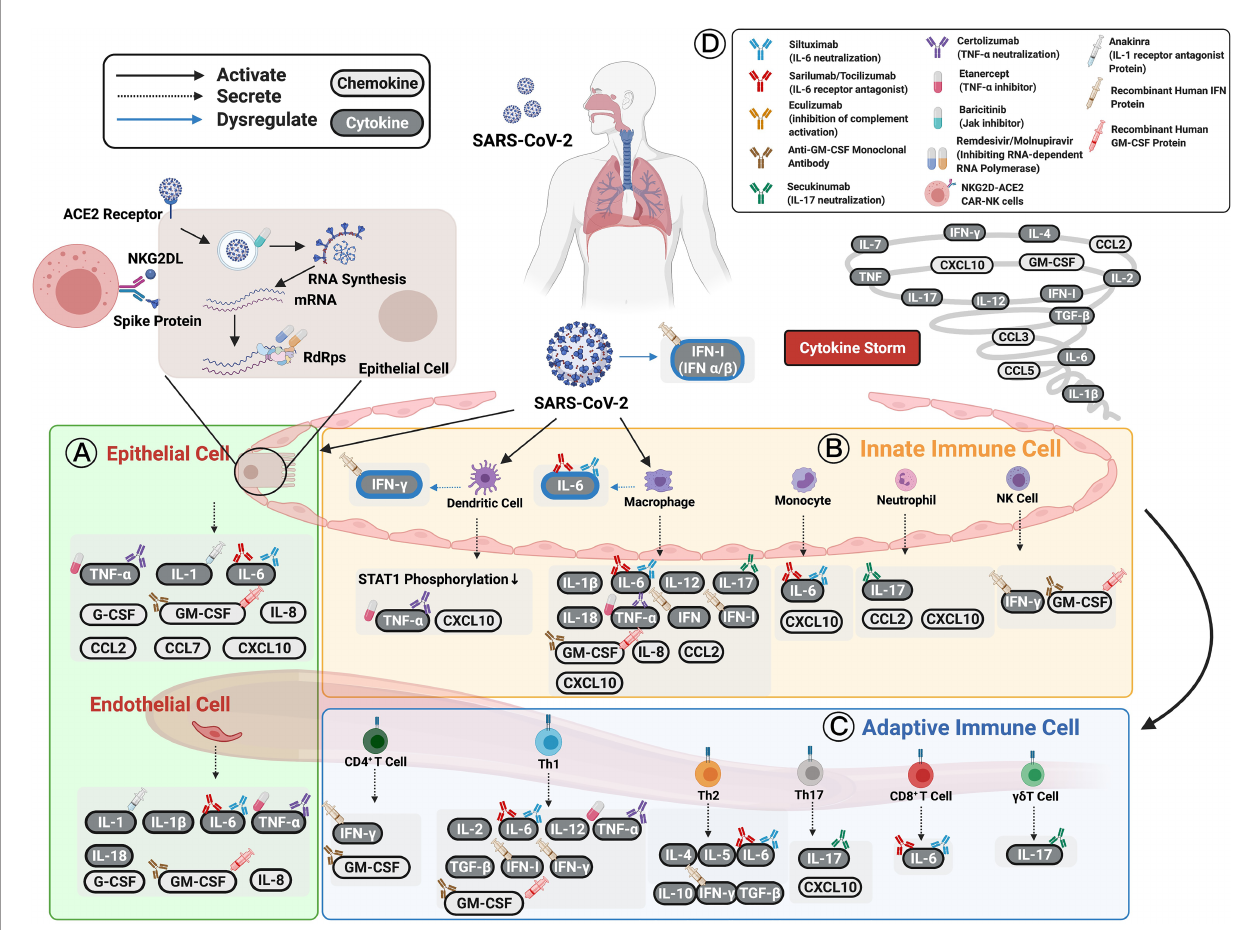
FIGURE 1 | Cytokines and chemokines expression induced by SARS-CoV-2 in patients with COVID-19. (A) Epithelial cells have been shown to express TNF- a , IL-1, IL-6, and other chemokines (e.g., IL-8, CCL2, CCL7, CXCL10, G-CSF, and GM-CSF) as well as initiate immune responses following infection. (B) Innate immune cells, including dendritic cells, macrophages, circulating monocytes, neutrophils, and NK cells, are activated by SARS-CoV-2 infection to secrete various cytokines and chemokines to enhance both innate and adaptive immune cells. (C) Adaptive immune cells consisting of functional CD4 + T cells, Th1 cells, Th2 cells, Th17 cells, CD8 + T cells, and gd T cells defend against SARS-CoV-2 infection. The cytokines and chemokines expressed by adaptive immune cells interact in a positive feedback loop to strengthen innate immune responses. The cellular origin of each cytokine and its regulatory roles are shown in fi gure and Table 1 . The persistent escalation of these responses leads to uncontrolled cytokine and chemokine expression, resulting in a life-threatening systemic in fl ammatory response syndrome, also known as “ cytokine storm ” . (D) Selected cytokine/chemokine modulation drugs that have been applied in COVID-19 clinical trials are shown in the upper right of the fi gure. They include neutralized antibodies (siltuximab, secukinumab, certolizumab); receptor antagonists (anakinra, sarilumab, tocilizumab), human recombinant proteins (IFN- b -1 a , IFN- a -1 b , IFN- a -2 b ); small-molecule drugs (baricitinib, remdesivir, molnupiravir, etanercept); and cell therapy (NKG2D-ACE2 CAR-NK cells). The drugs have been applied to COVID-19 patients to boost their immune systems and inhibit viral replication or cytokine storms. Figure created with